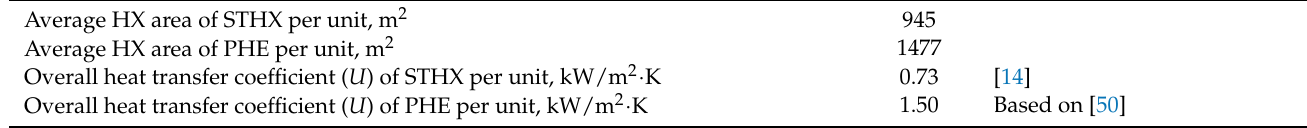
Table 12. The influence of the lean/rich heat exchanger ∆ T min on the thermal load and area of the